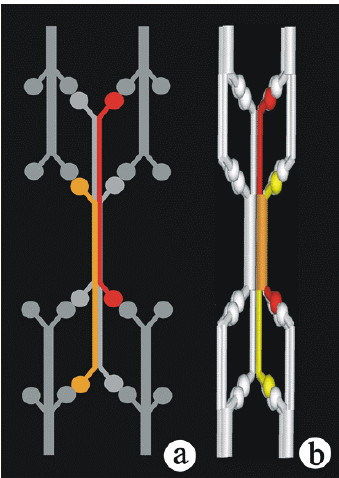
FIGURE 10. (a) Two-dimensional diagram of the collagen arrangement in the dogfish egg case. Two monomers are highlighted in red and yellow, and their laterally interacting parts in orange. Monomers associate laterally to form octamers, with four molecules axially shifted by 15 nm. Interactions between different octamers occur via their globular domains. ( b) As in (a) but in three